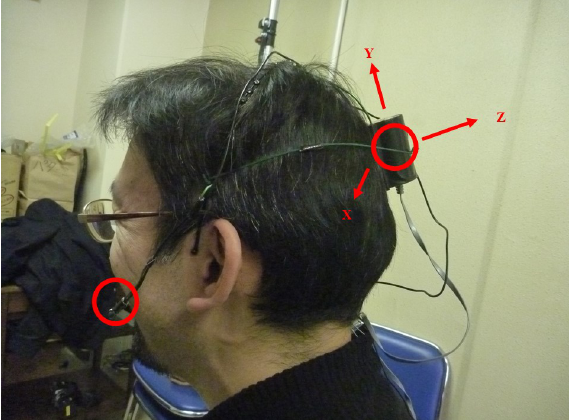
Figure 2. A microphone (DPA 4060-108BM) was placed near the mouth for high-quality recording. A triaxial analog accelerometer (Kionix KXM52-1050) in a protection case was mounted in the occipital region. The top face of the sensor was directed toward the Z-axis. The microphone and the sensor were directly wired to an 8-channel A/D recorder (NF circuit block, EZ7510) through coaxial and LAN